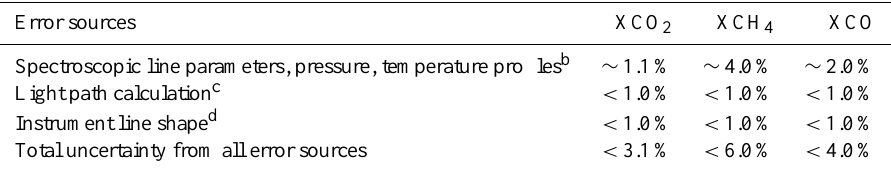
Table 3. Estimated measurement accuracy a . Error sources XCO 2 XCH 4 XCO Spectroscopic line parameters, pressure, temperature profiles b ∼ 1.1% ∼ 4.0% ∼ 2.0% Light path calculation c < 1.0% < 1.0% < 1.0% Instrument line shape d < 1.0% < 1.0% < 1.0% Total uncertainty from all error sources < 3.1% < 6.0% <